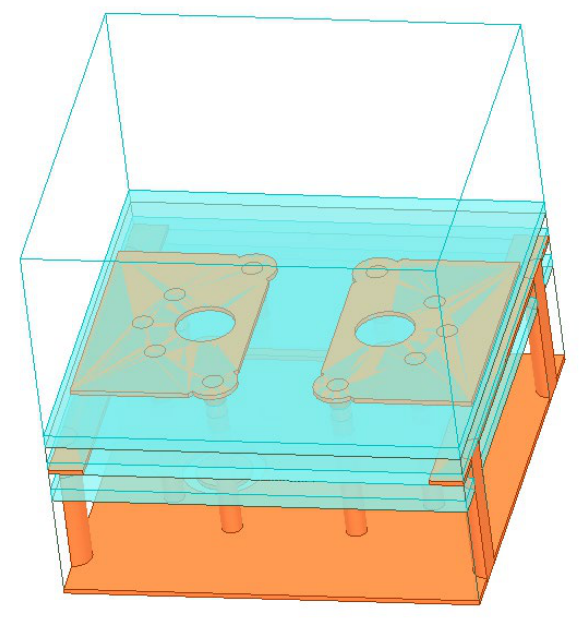
Figure 3. Single-polarized magnetoelectric dipole antenna.